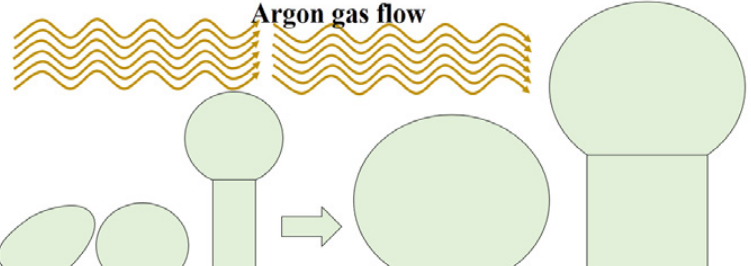
Fig. 10. The schematic of the joining catalyst droplets owing to the increased pressure of the crucible with increasing temperature and its effect on the diameter of the wires